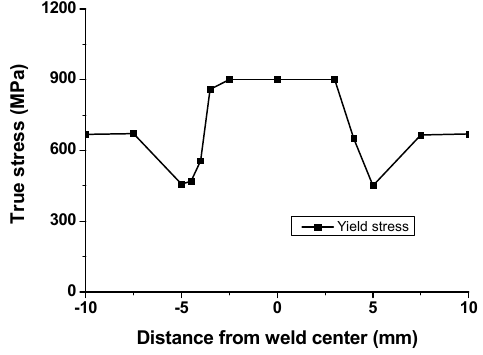
Figure 12. Yield stress obtained by DIC across the FSW joint.